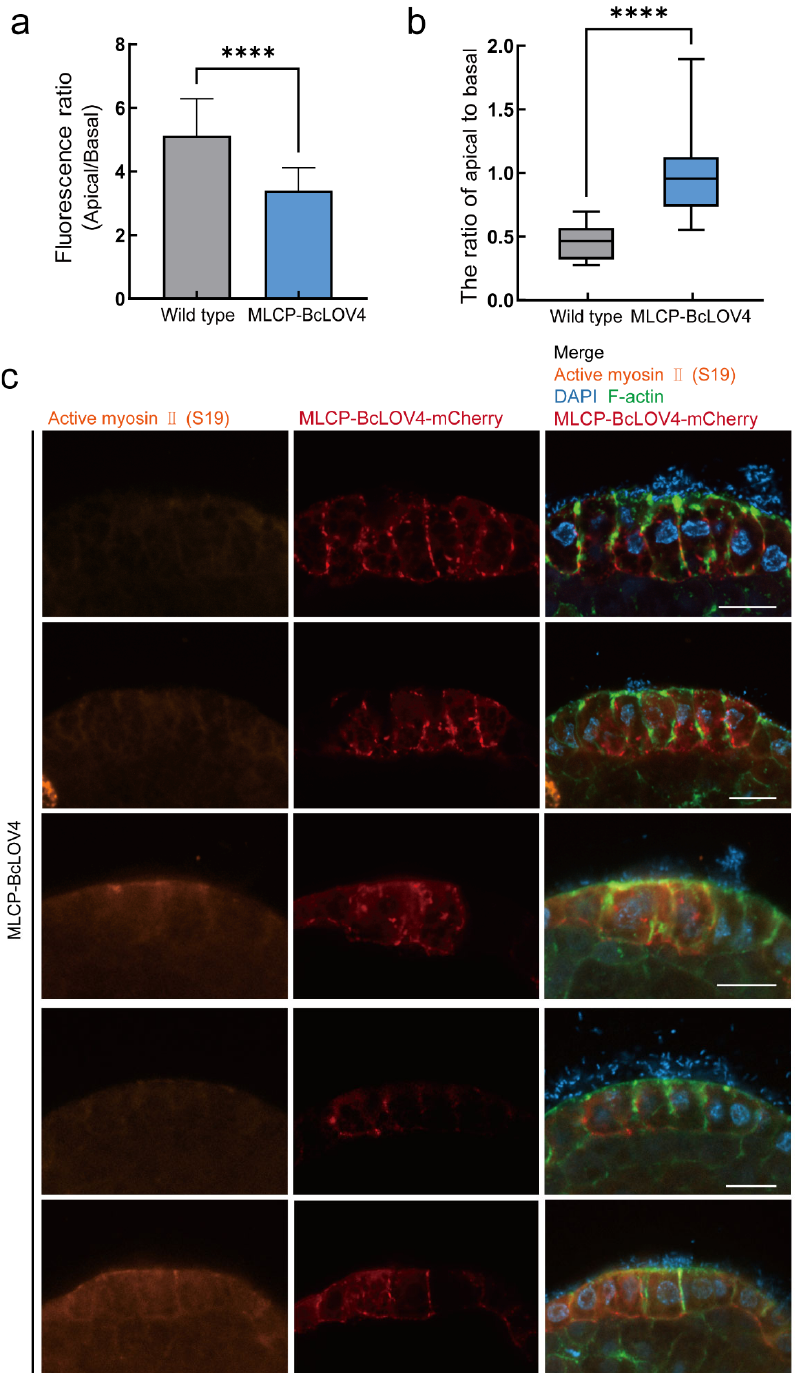
Figure A2. MLCP ‐ BcLOV4 system disrupted atrial siphon invagination via abolishing apical con ‐ traction in Ciona larvae. ( a ) Quantification of fluorescence ratio (apical/basal) of active myosin II signal of wild type and MLCP ‐ BcLOV4 ‐ expressed group after 60 min of exposure to 0.5% blue light. ****, p < 0.0001 (student’s t ‐ test). n = 14 cells. ( b ) The ratio of the apical length to basal length of vertical section of atrial siphon apical contraction in the MLCP ‐ BcLOV4 ‐ expressed group and wild type after 60 min of exposure to 0.5% blue light. ****, p < 0.0001 (student’s t ‐ test). n = 14 cells. ( c ) Five representative images of myosin immunofluorescence assay of the Ciona atrial siphon in the MLCP ‐ BcLOV4 system group. Scale bar, 10 μ m.